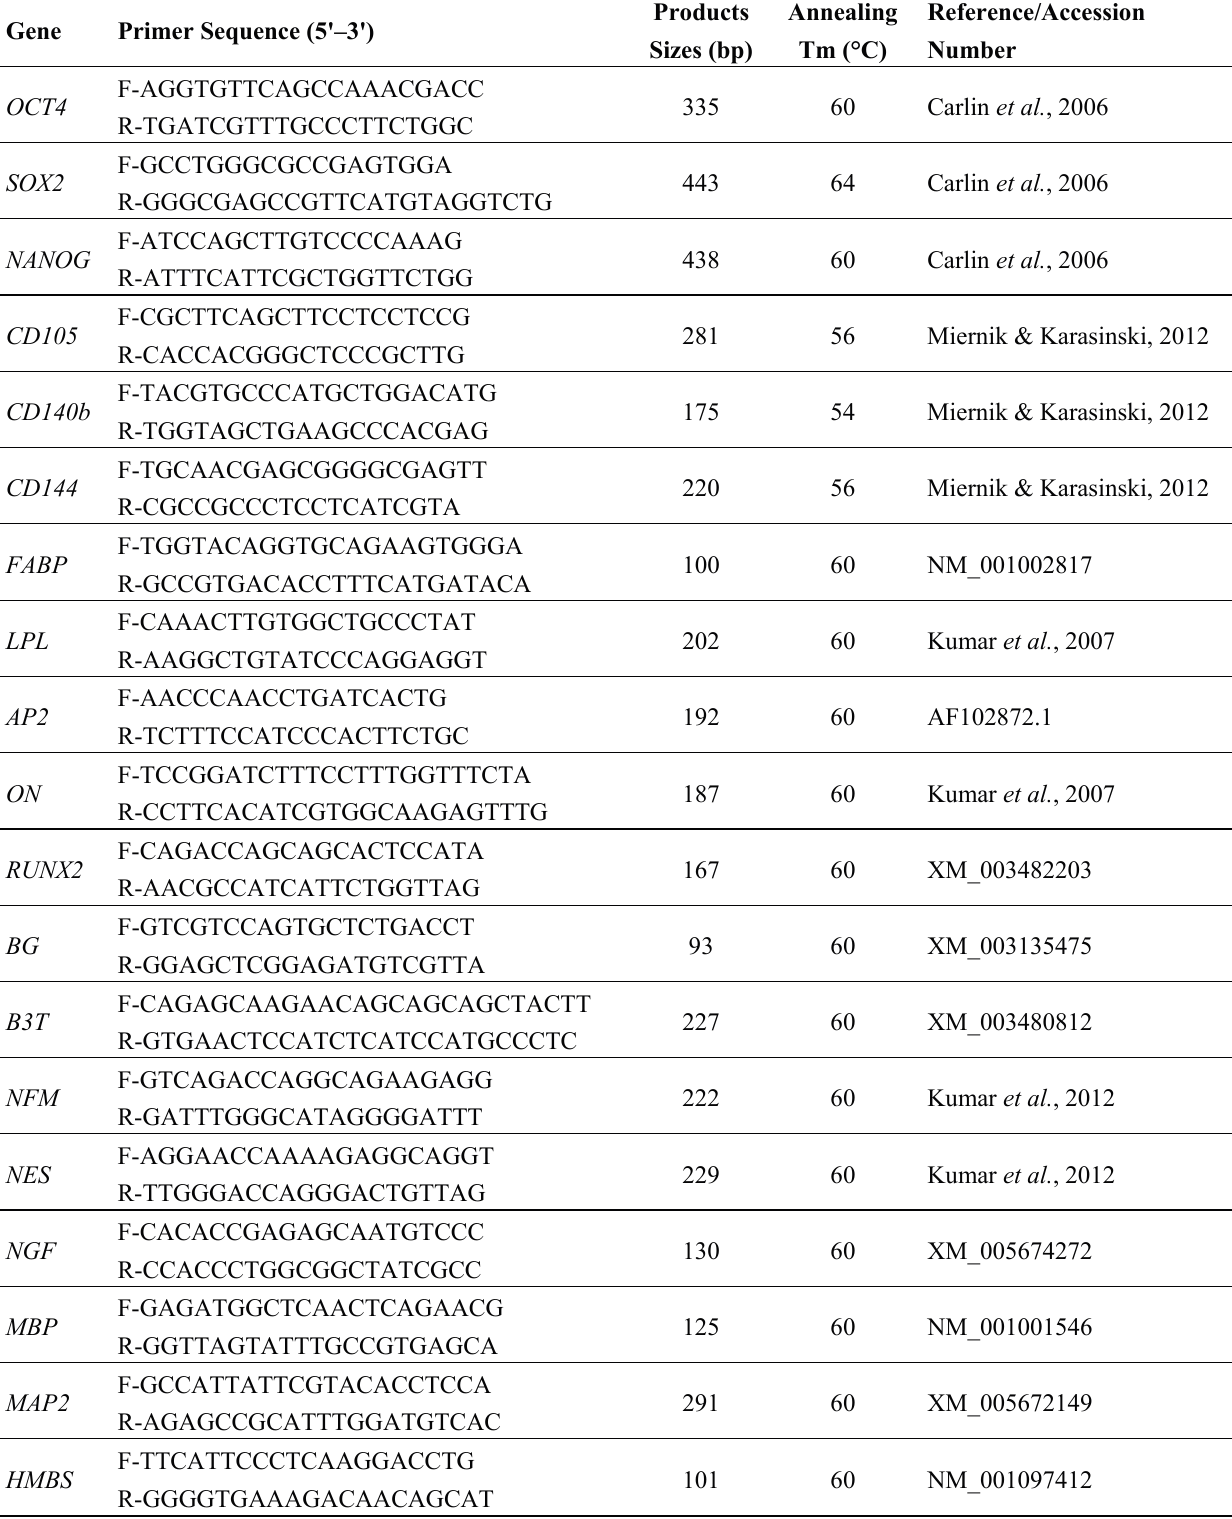
Table 1. RT-PCR and RT-qPCR primers sequences specific to porcine MSCs and differentiated